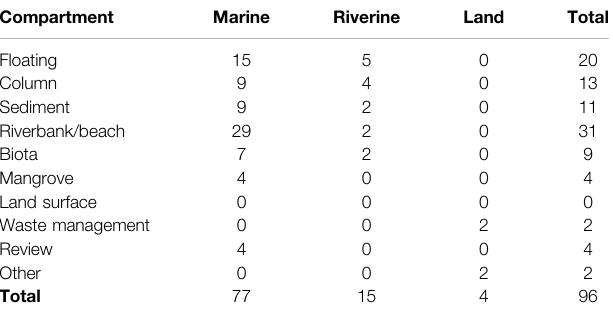
TABLE 2 | Overview of studies included in the meta-analysis, categorized by the environmental system and relevant sub-compartment that is studied. Totals add up to over 83 since a handful of studies quanti fi ed multiple environmental compartments and/or environmental systems. Note, review category includes studies that present overviews of a subset of studies included in this papers (e.g. fl oating plastic in marine